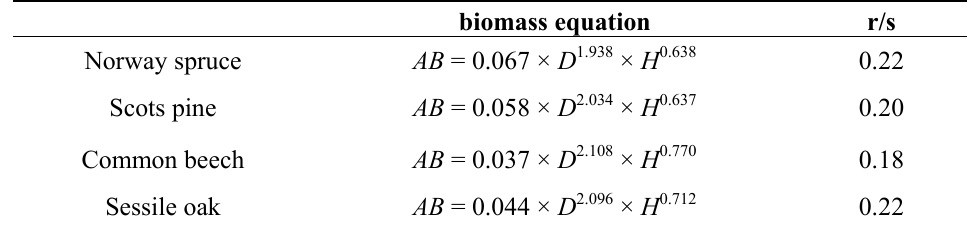
Table 2. Biomass equations and root/shoot (r/s) factors used in this study; AB = aboveground biomass. biomass equation r/s Norway spruce AB = 0.067 × D 1.938 × H 0.638 0.22 Scots pine AB = 0.058 × D 2.034 × H 0.637 0.20 Common beech AB = 0.037 × D 2.108 × H 0.770 Sessile